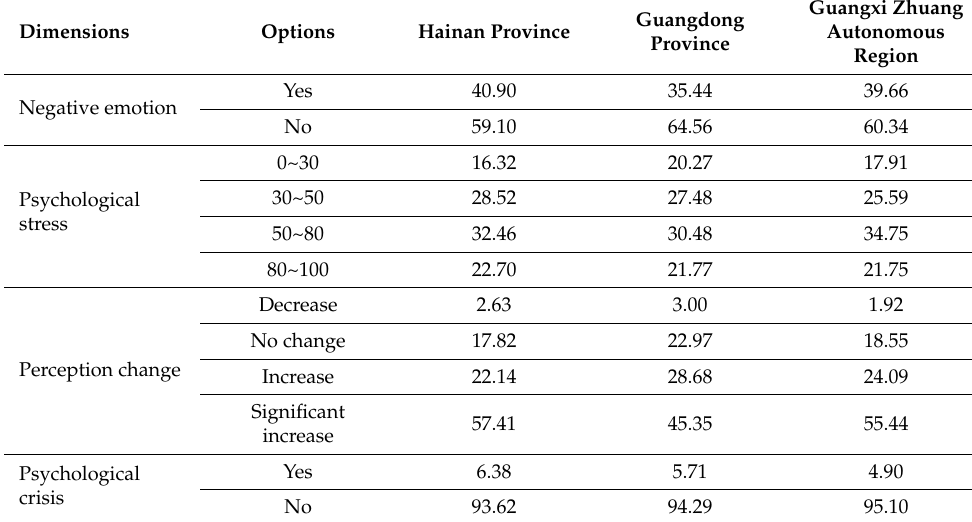
Table 2. Psychological status in each